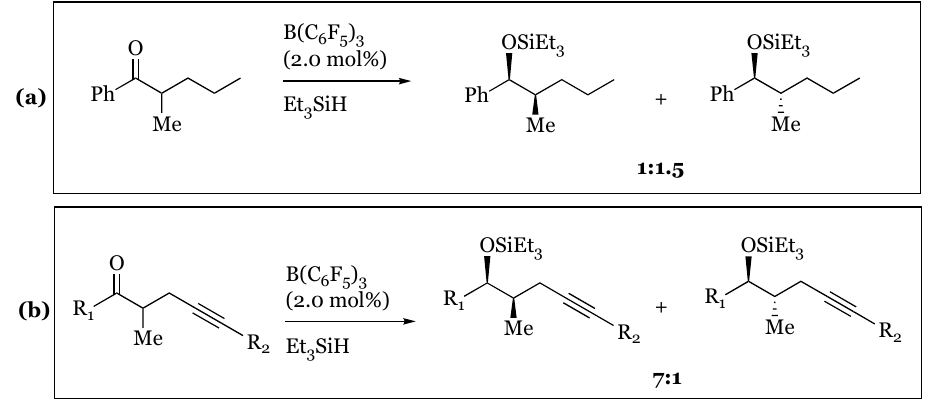
Figure 27. Diastereoselectivity: ( a ) without sigma-pi chelation; ( b ) with sigma-pi chelation. R 1 = Ph and R 2 = H.